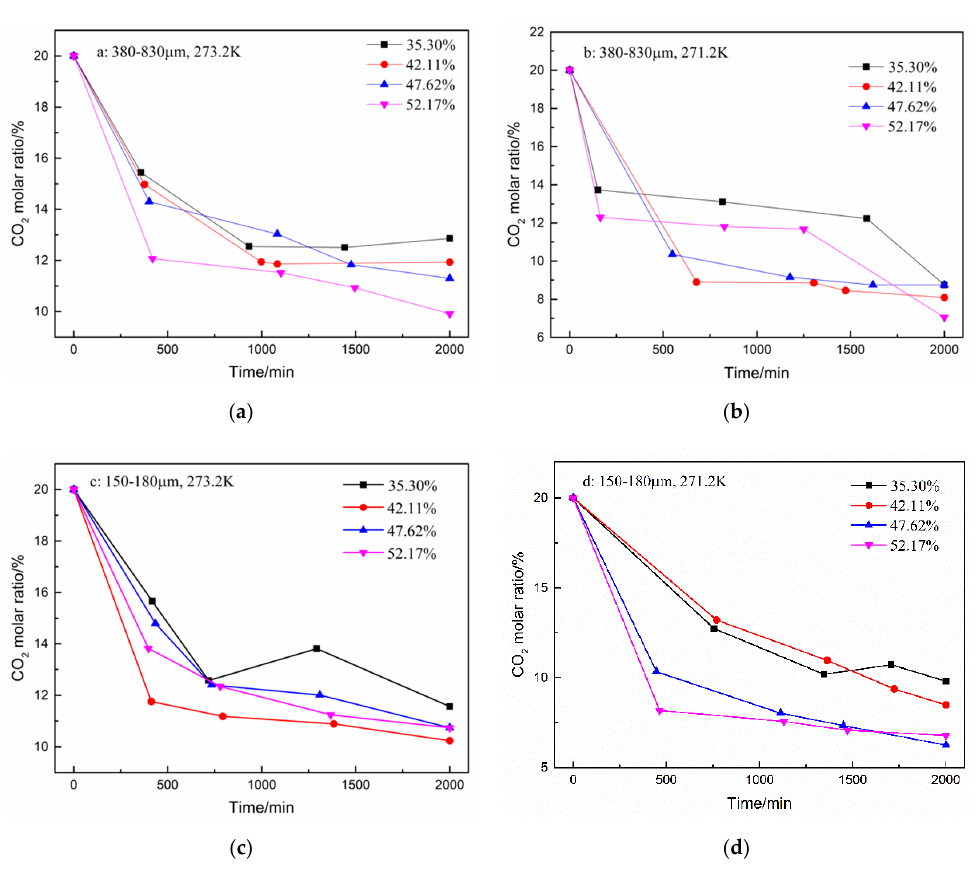
Figure 4. CO 2 molar ratio in the gas phase after hydrate formation under different conditions. ( a ): 380–830 μ m, 273.2 K; ( b ): 380–830 μ m, 271.2 K; ( c ): 150–180 μ m, 273.2 K; and ( d ): 150–180 μ m, 271.2 K.